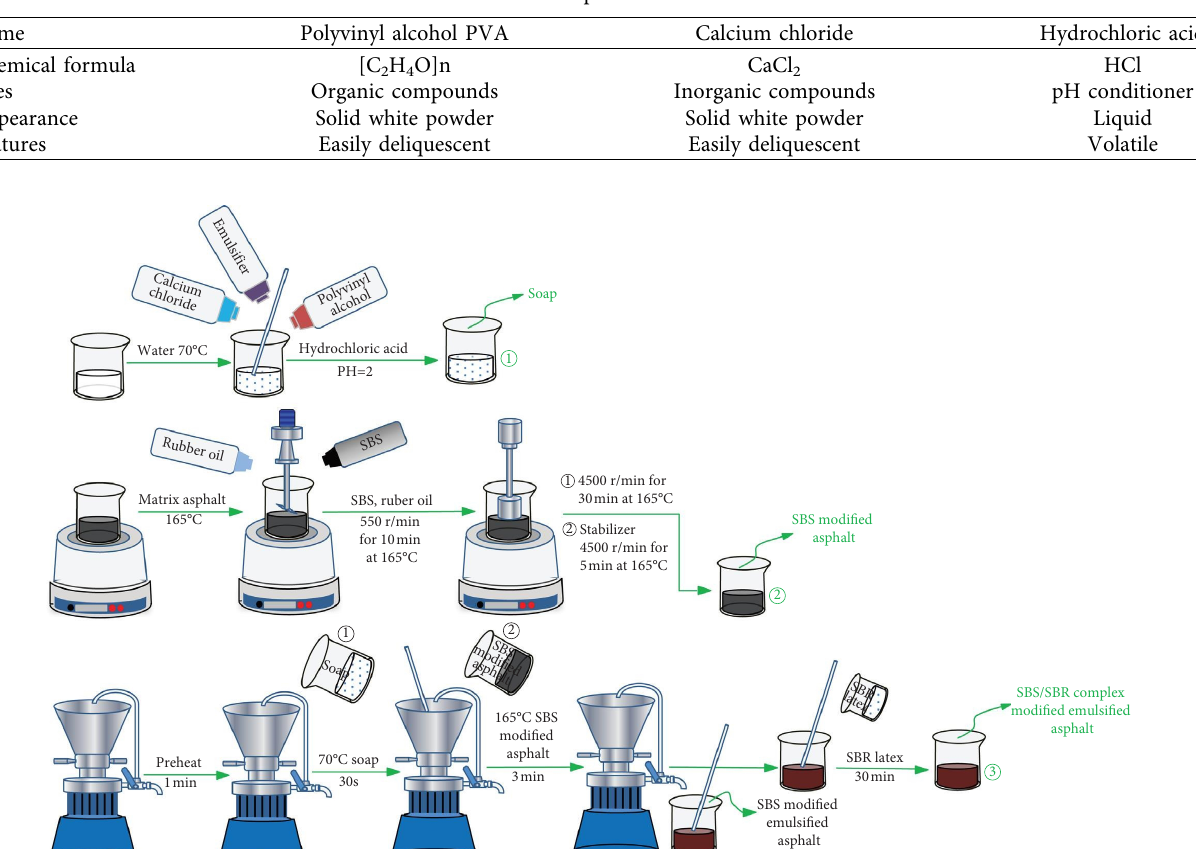
Figure 1: Preparation process of SBS/SBR modifed emulsifed